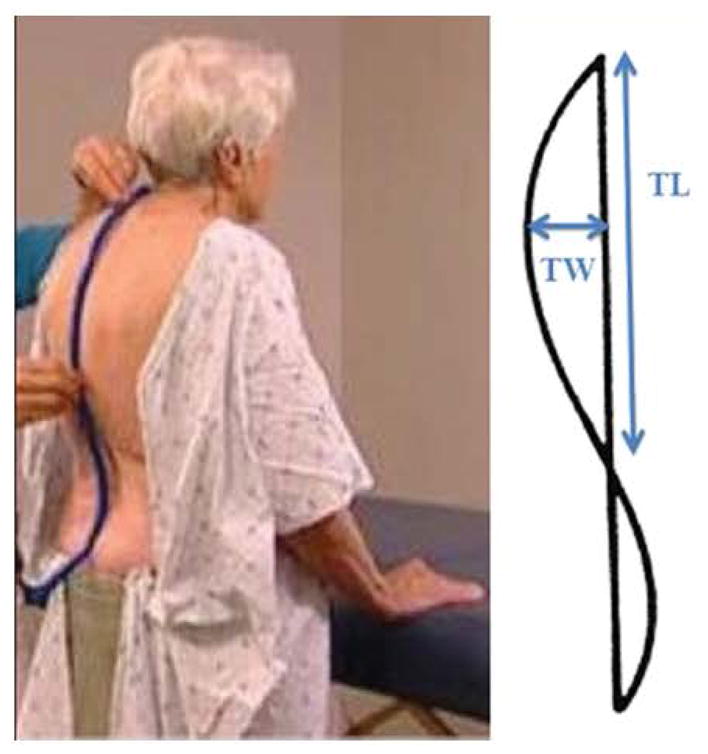
Flexicurve measure of kyphotic postureFlexicurve ruler and traced contour on graph paperTL: Thoracic lengthTW: Thoracic widthSource: Reprinted Katzman et al., (2010).